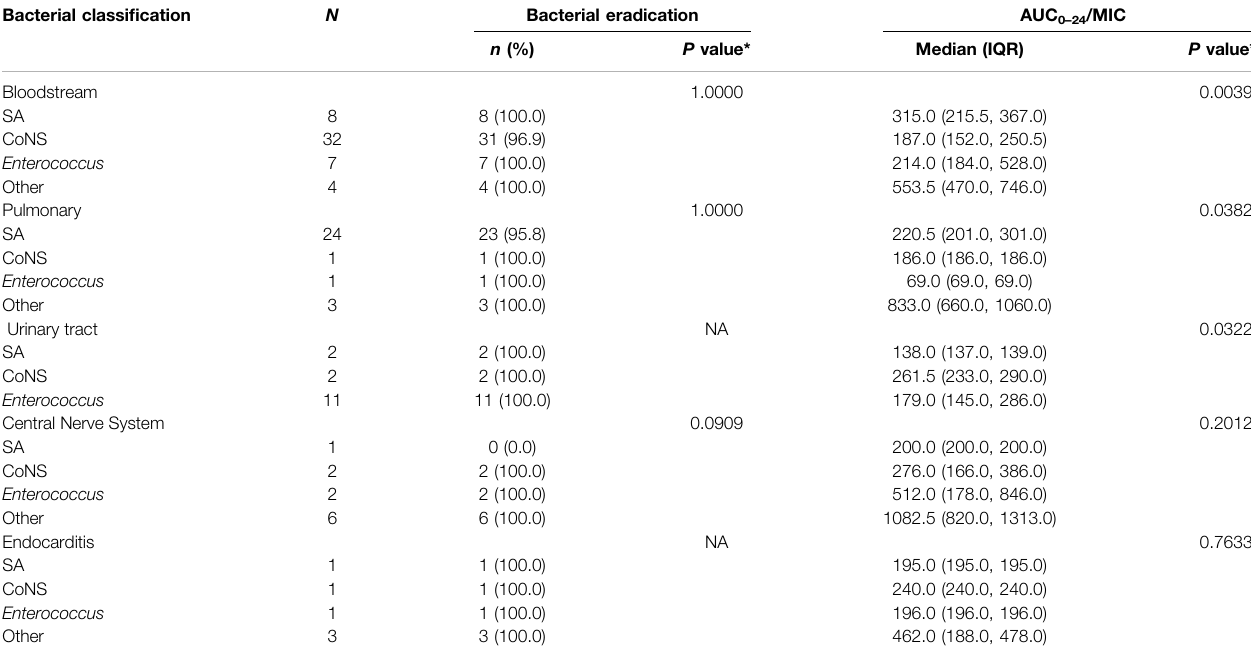
TABLE 5 | Summary of bacterial response of vancomycin and AUC 0 – 24 /MIC by the most common infection sites and bacteria. Bacterial classi fi